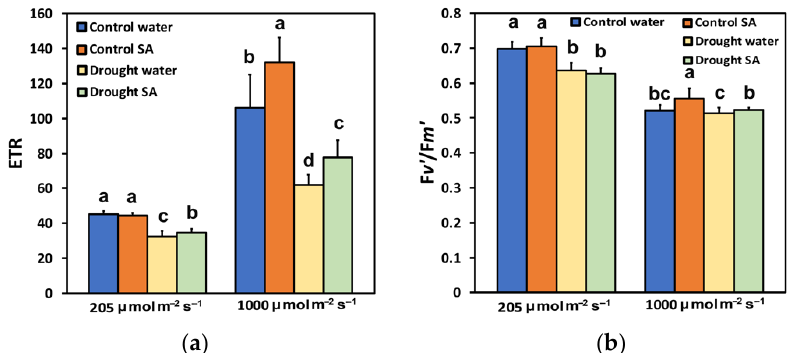
Figure 4. The electron transport rate (ETR) ( a ); and the efficiency of excitation energy capture by the open PSII rection centers (F v ’/F m ’) ( b ); of oregano seedlings grown under optimal conditions (control) or moderate drought stress (MoDS), and sprayed by 1 mM SA or H 2 O. ETR and F v ’/F m ’ were estimated at 205 (LL) or 1000 (HL) µ mol photons m –2 s –1 actinic light (AL) intensity. Error bars represent standard deviations ( n = 4). Different lowercase letters, within the same light treatment, represent statistical difference ( p < 0.05). Τ he efficiency of excitation energy capture by the open PSII rection centers (F v ’/F m ’)